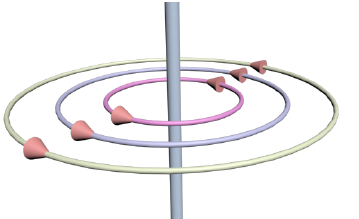
Figure 2. Magnetic field around the long straight